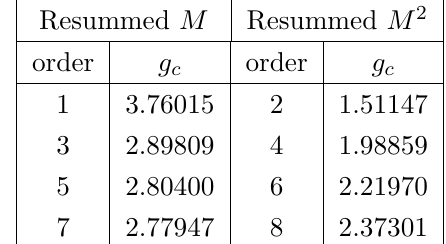
Table 2 . Critical couplings obtained from the OPT resummation of M ( M 2 ) at odd(even)